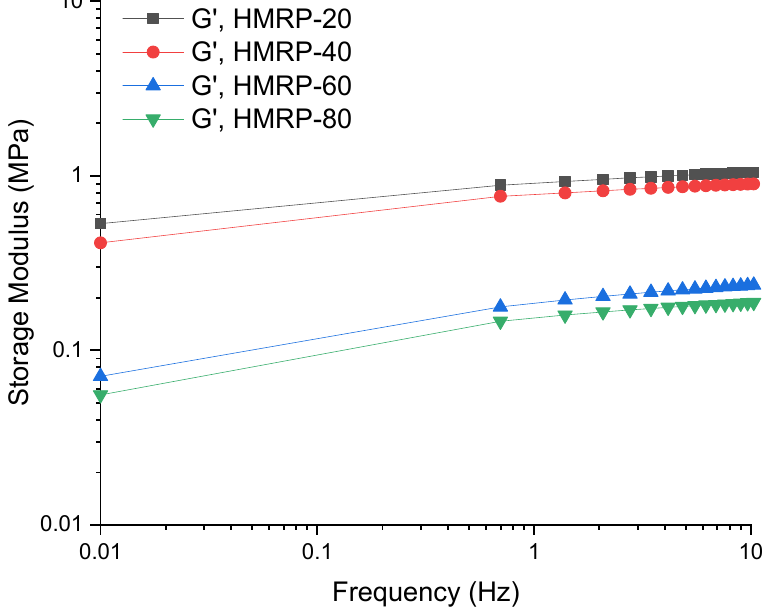
Figure 4. Shear storage modulus of PVA-based MRP samples with different ratios of DMSO:water under continuously changing frequency.